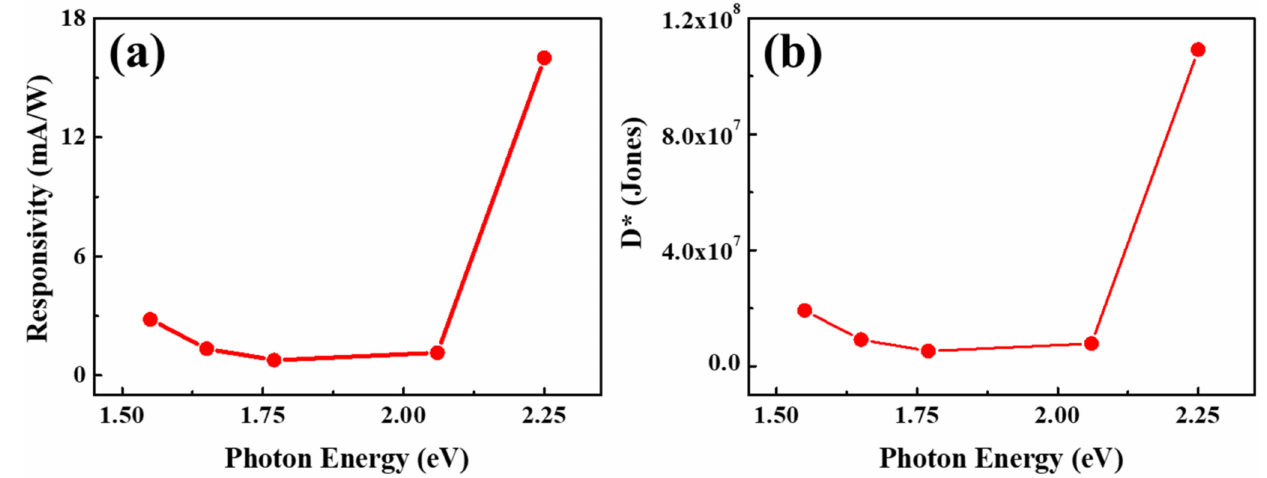
Figure 6. ( a ) Responsivity variation characteristics of NbAs photoelectric device prototype within 1.5 to 2.25 eV. ( b ) The relationship between the detection rate D* of NbAs devices and the energy of incident